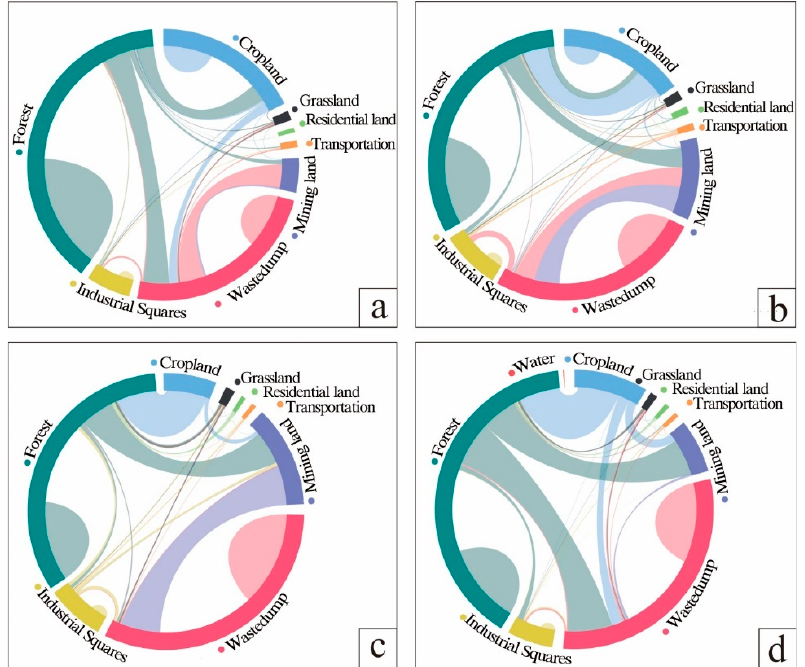
Figure 8. Relationship between land use type changes in Heidaigou mining. ( a ) 2006–2011; ( b ) 2011–2016; ( c ) 2016–2021; and ( d ) 2006–2021.